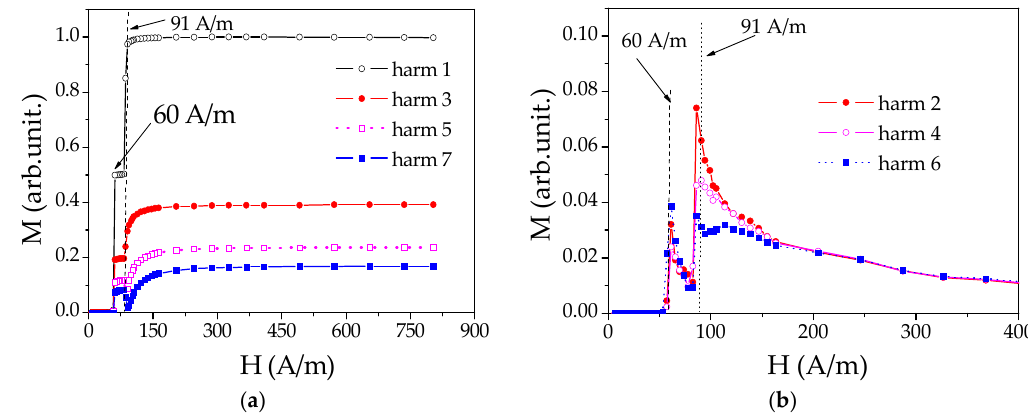
Figure 6. Dependences of odd harmonics ( a ) and even harmonics ( b ) on magnetic field amplitude in Fe 74 B 13 Si 11 C 2 microwires ( d = 19.4 μ m). Reprinted with permission from [51].